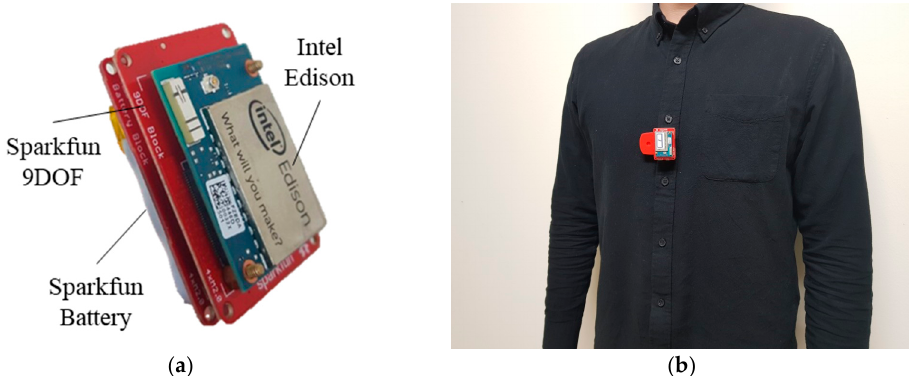
Figure 2. Overview of the apparatus. ( a ) Packaging of the Intel Edison, Sparkfun 9DOF, and Sparkfun Battery; ( b ) Appearance of the apparatus when worn by participant.